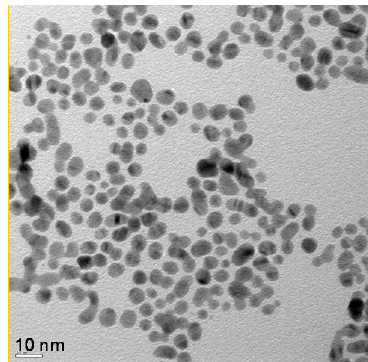
Figure 2. TEM image of Au-NPs. Nanoparticles are roughly spherical.